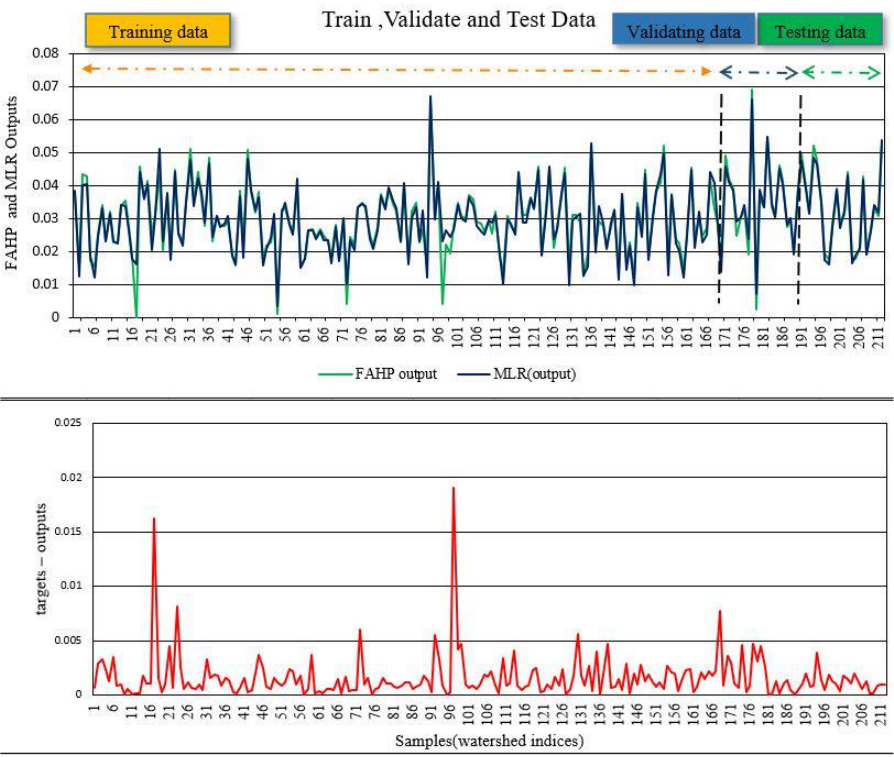
Figure 6. MLR performance for training, validating, and testing data. Table 3. Performance of the machine learning algorithms.